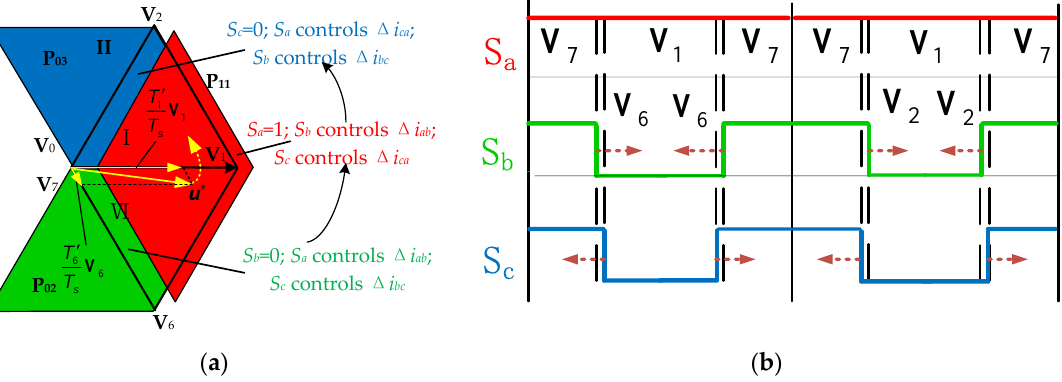
Figure 7. Smooth transition of voltage-space-vectors and the operation of three-phase switches. ( a ) u * moves from region VI to region I; ( b ) the operation process of the three-phase switches.